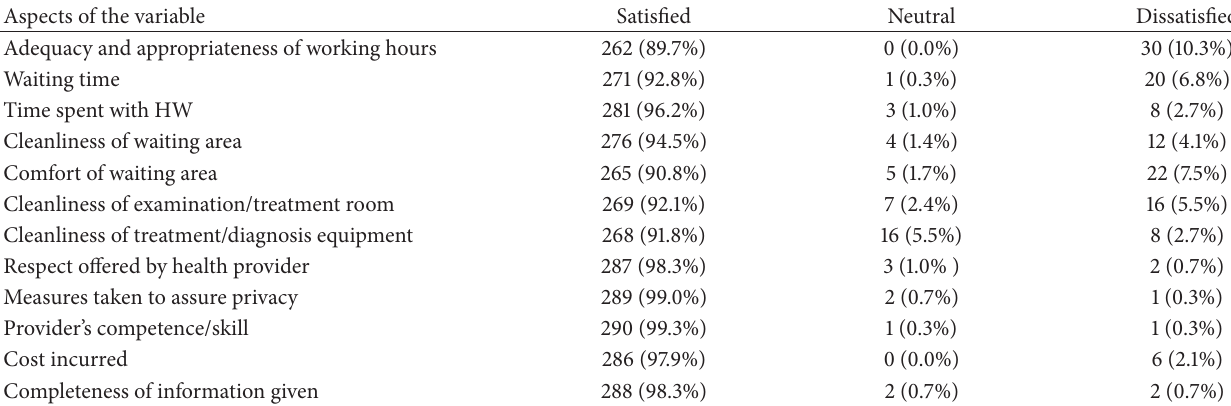
Table 4: TB patients’ satisfaction level with different components of services in private health facilities of A. A,